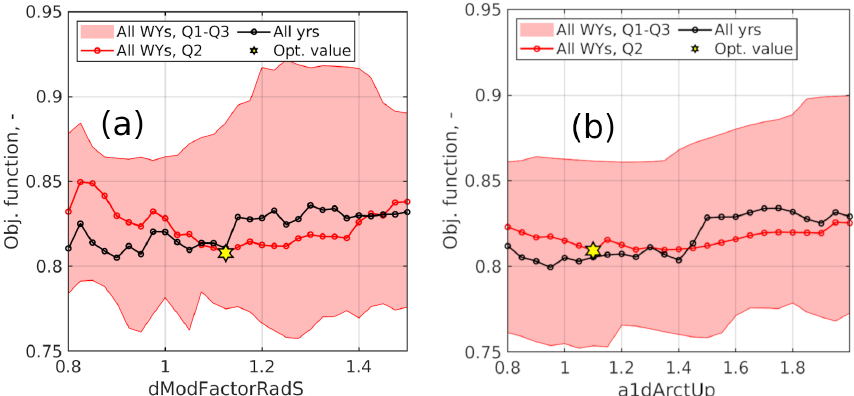
Figure 4. Calibration objective metrics as a function of parameter values, with dModFactorRadS being m (cid:48) the Supplement for details on the model’s notation in the source code). Parameter m (cid:48) each parameter value (cid:50) , the objective metric was computed using both all data from all years in one sample and separately for each water year (all-year and yearly values, respectively). Q1, Q2, and Q3 are the first, second, and third quartiles of objective metrics across all water years. WY is water